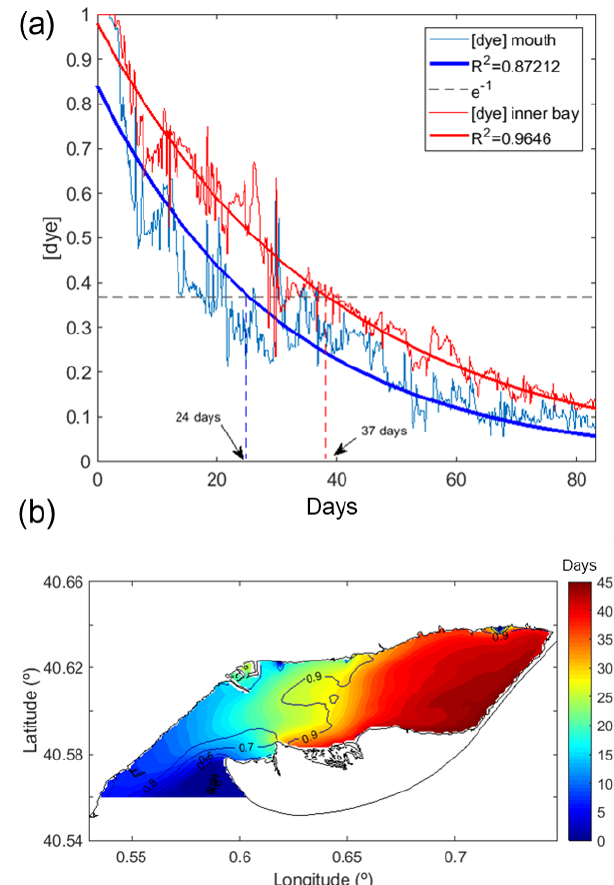
Figure 4. (a) Time evolution of the dye concentration at two points – at the bay mouth and inside the bay – and the corresponding ex- ponential fitting (with the squared correlation shown in the legend) used to obtain the LFT for the C case. (b) The local e -flushing time for the C case (colour). The black contour shows the squared corre- lation obtained at each of the grid